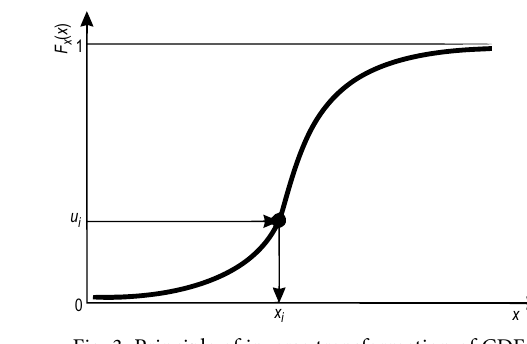
Fig. 3. Principle of inverse transformation of CDF